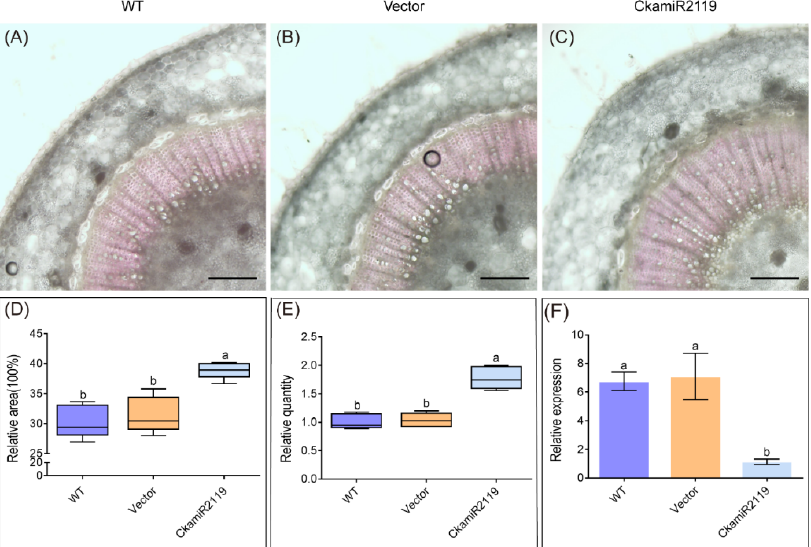
Figure 5. Safranin staining of freehand sections of stems of CkamiR2119-OE line under drought stress. ( A ) WT. ( B ) Empty vector. ( C ) CkamiR2119-OE line. ( D ) The relative area of the xylem in stems. ( E ) The ratio of CkamiR2119-OE line and empty vector plants to the number of vessels in the wild-type. ( F ) The relative expression of tobacco BI-1 gene in tobacco plants after drought treatment. Data are shown as the mean ± SD of three independent experiments. One-way ANOVA was performed for the statistical analysis, where different letters represent significant differences ( p < 0.05). Scale bars, 300 µ